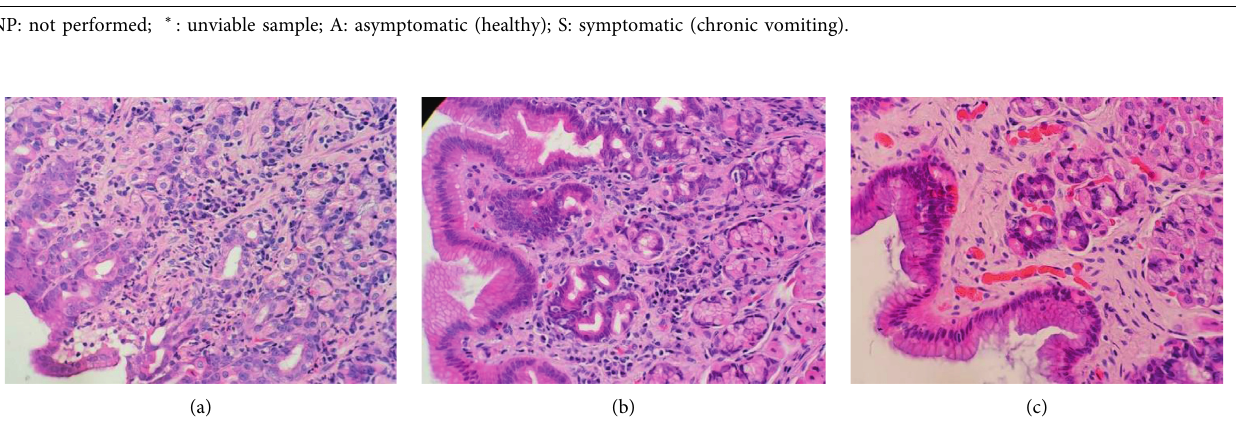
Figure 2: Gastric mucosa (body, A and B; antrum, C) biopsy sections. (a) Lamina propia with a high quantity of polymorphonuclear cells (asterisk), mainly eosinophilic infiltrate. (b) Lamina propia showed a high quantity of mononuclear cells (asterisk), with a predominance of plasmocytes. (c) Image of the normal gastric mucosa. (Haematoxylin and eosin stain, ×